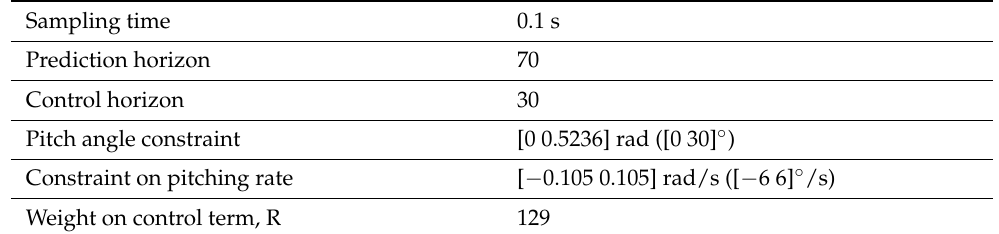
Table 2. MPC parameters.